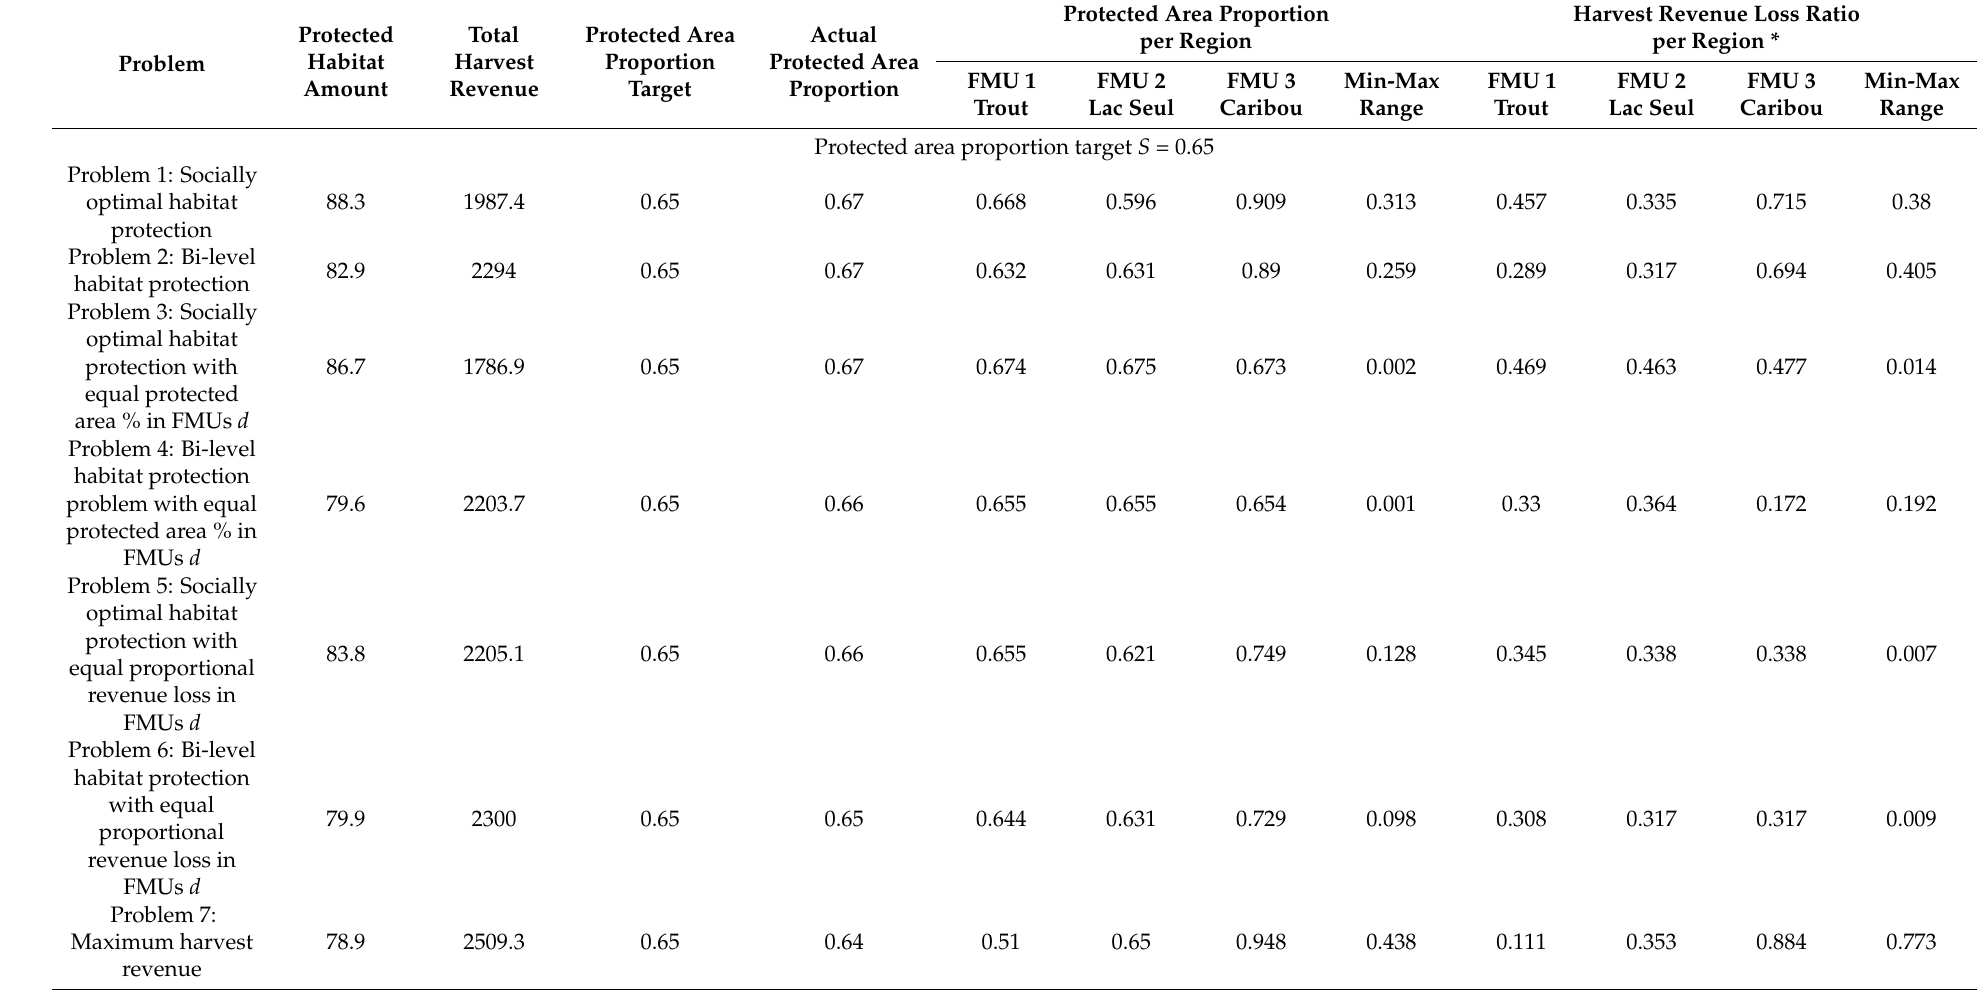
Table 4. Harvest revenue, protected habitat amount and FMU-specific harvest revenue loss ratios * between the revenue is protection and no-protection scenarios.